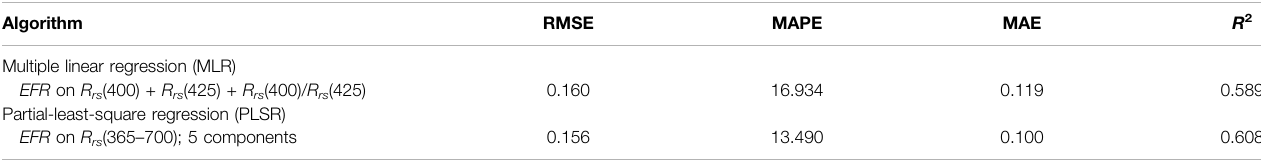
TABLE 3 | Summary statistics associated with the performance comparison of the two EFR algorithms (see also Figure 11 and Supplementary Figure S10 ). Statistics include root mean squared error (RMSE), mean average percent error (MAPE), mean absolute error (MAE), and R -squared for each algorithm.